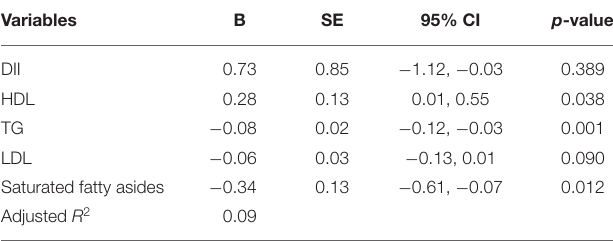
TABLE 6 | Summary of linear regression analysis based on EF as outcome.